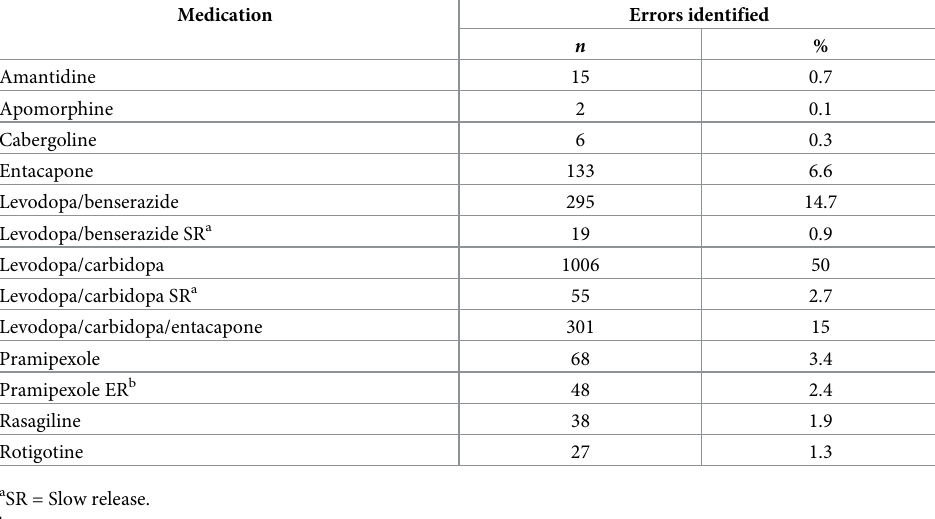
Table 4. Frequency of medication administration errors during admission, listed by medication.